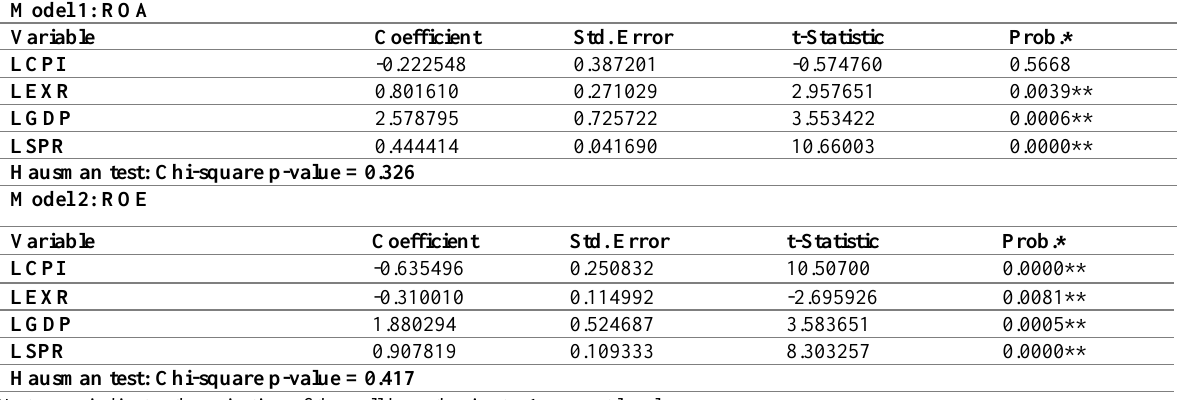
Table 2: Long run Results for Model 1 (ROA) and Model 2